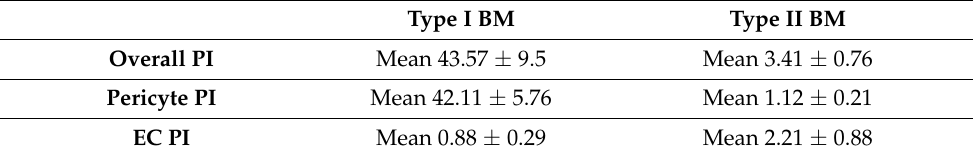
Table 1. Proliferation Index (PI) in bizarre microvasculature (BM) of